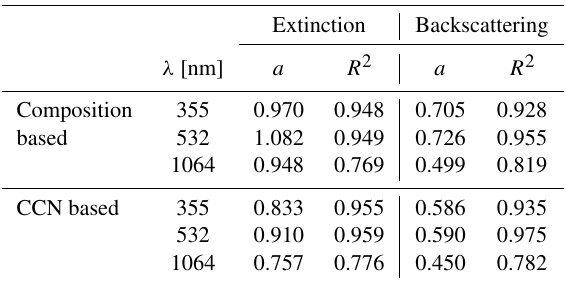
Table 6. Parameters of the correlation of the Mie-based and the lidar-based optical properties. Hygroscopicity derived on the ba- sis of the chemical composition and CCNc measurements on the ground. a is the slope of the linear fit and R 2 is the correlation co-